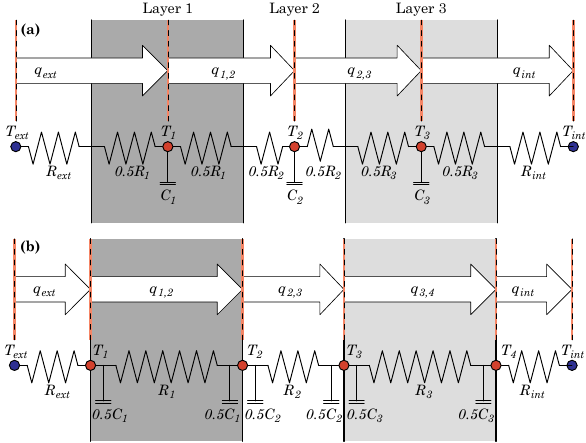
Figure 1. Conceptual diagram for two methods of discretising heat transfer through (three) homogeneous layers. (a) The half-layer scheme as commonly implemented in urban land surface models, and (b) the proposed interface scheme, which moves temperature nodes ( T k ) from the centre of layers to the interfaces between them, with heat capacity ( C i ) half of each adjacent layer. Discrete paths of conduction ( q k,k + 1 ) pass through layer resistances ( R i ) , while external/internal environment temperatures ( T ext / T int ) and surface thermal resistances ( R ext / R int ) control boundary fluxes ( q ext / q int